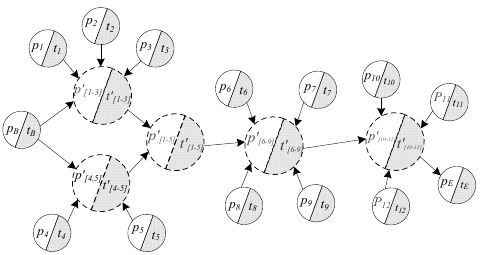
Figure 3. VWFA algorithm virtual reconfiguration process.